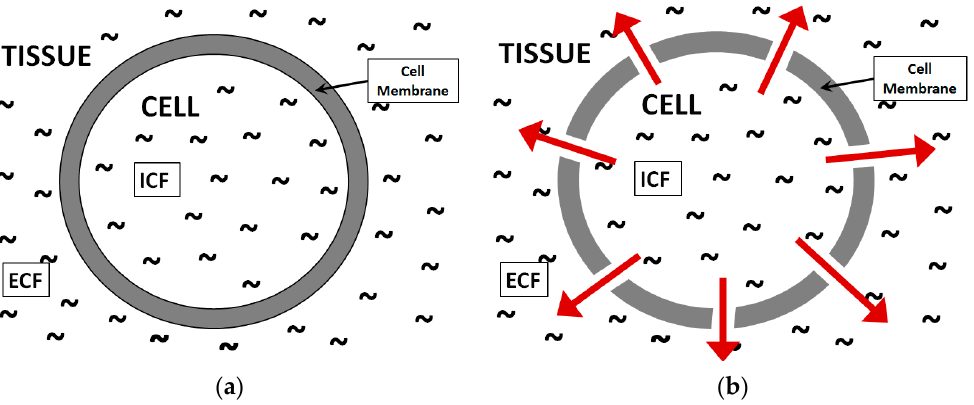
Figure 1. Fluids within a muscle, intracellular (ICF) and extracellular (ECF) compartment fluids. ( a ) Fresh muscle with intact cell membrane; ( b ) muscle with permeable cell membrane.